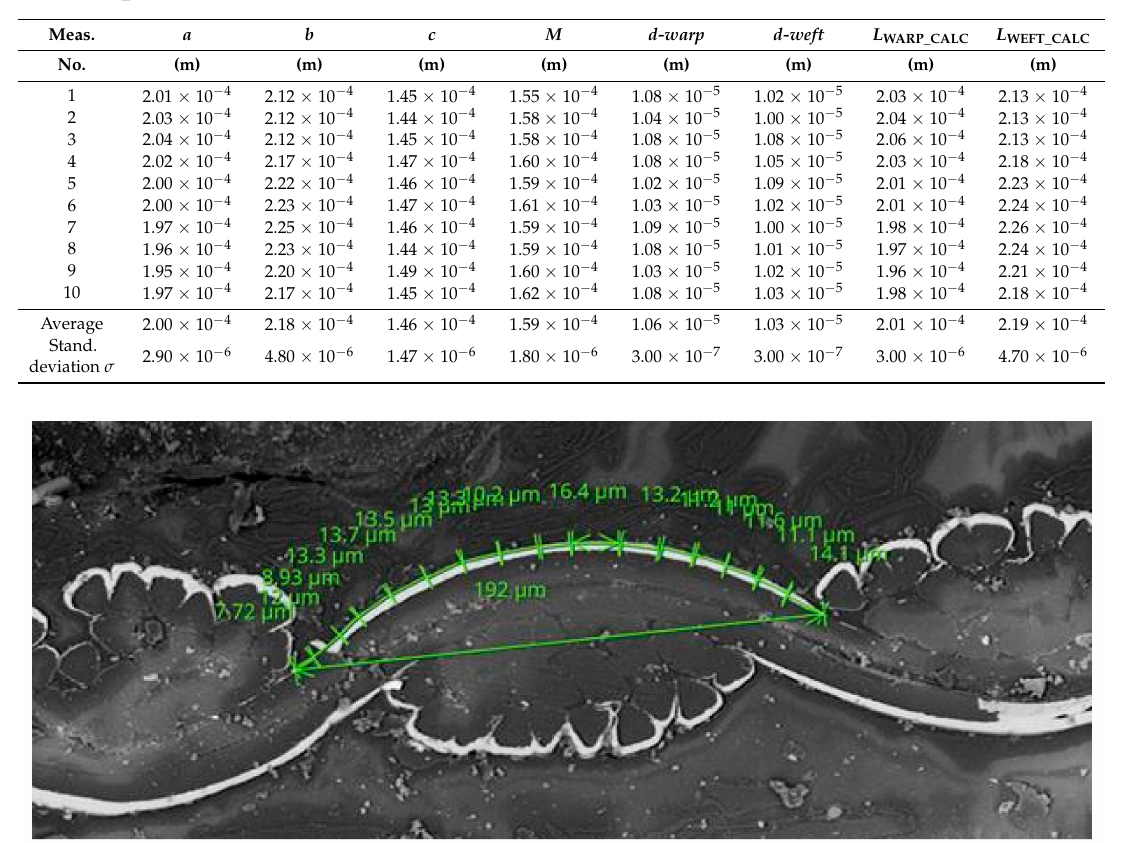
Figure 10. Measurement of the length of the warp for the sample RSKCuIv4. Table 6. The measurement results of the length of the warp L WARP_MEAS and the length of the line connecting the arcs in warp a -RSKCuIv4. Meas.